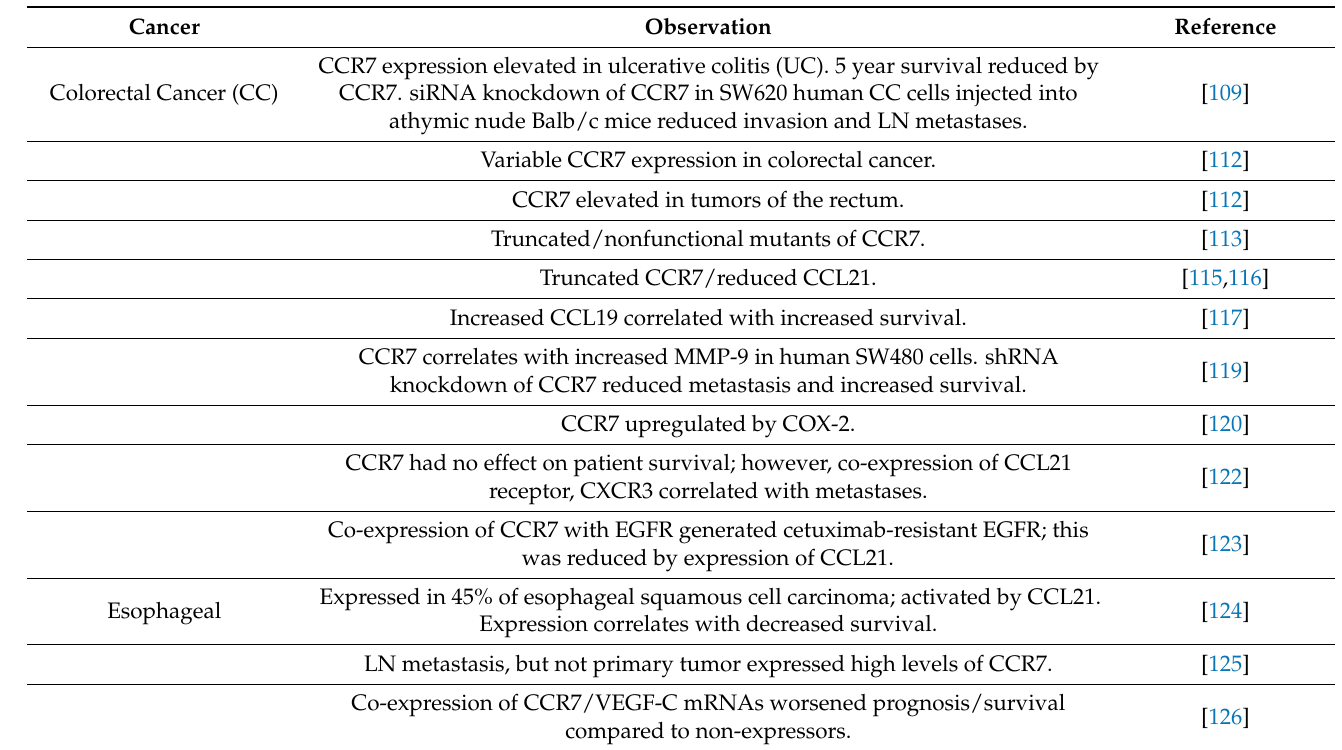
Table 3. CCR7 in Gastrointestinal